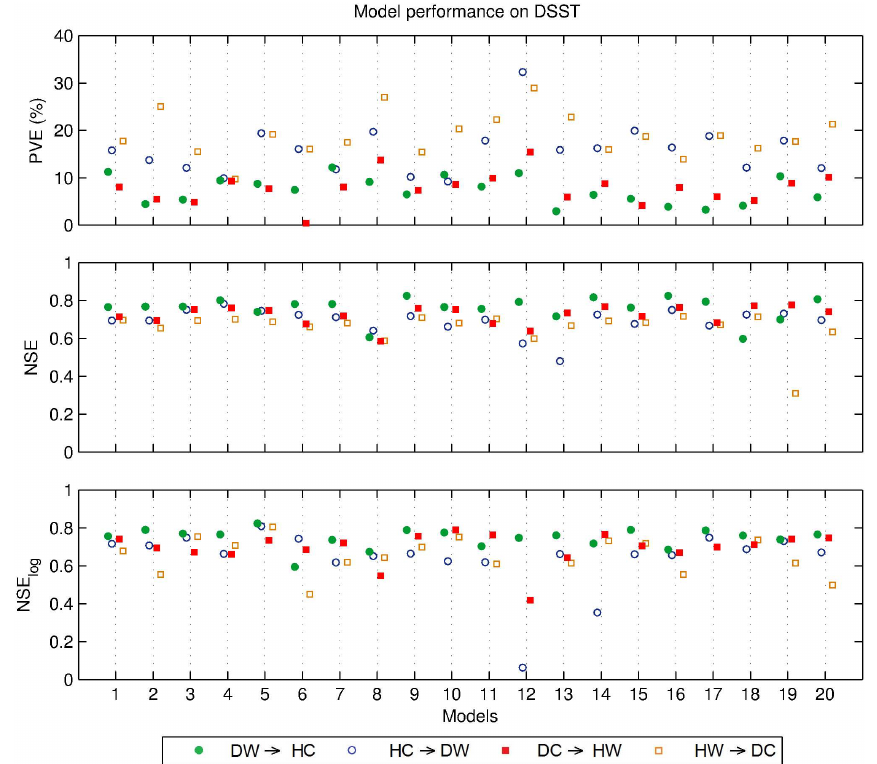
Fig. 7. Performance in validation (PVE, NSE and NSE log criterion) for the four DSST on the Au Saumon catchment (SAU). Negative values for NSE not